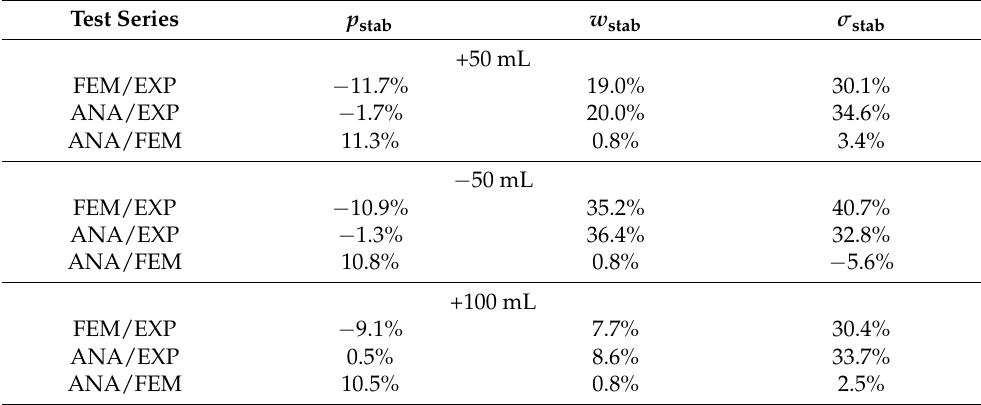
Table 4. Comparison of results from experimental research, numerical and analytical